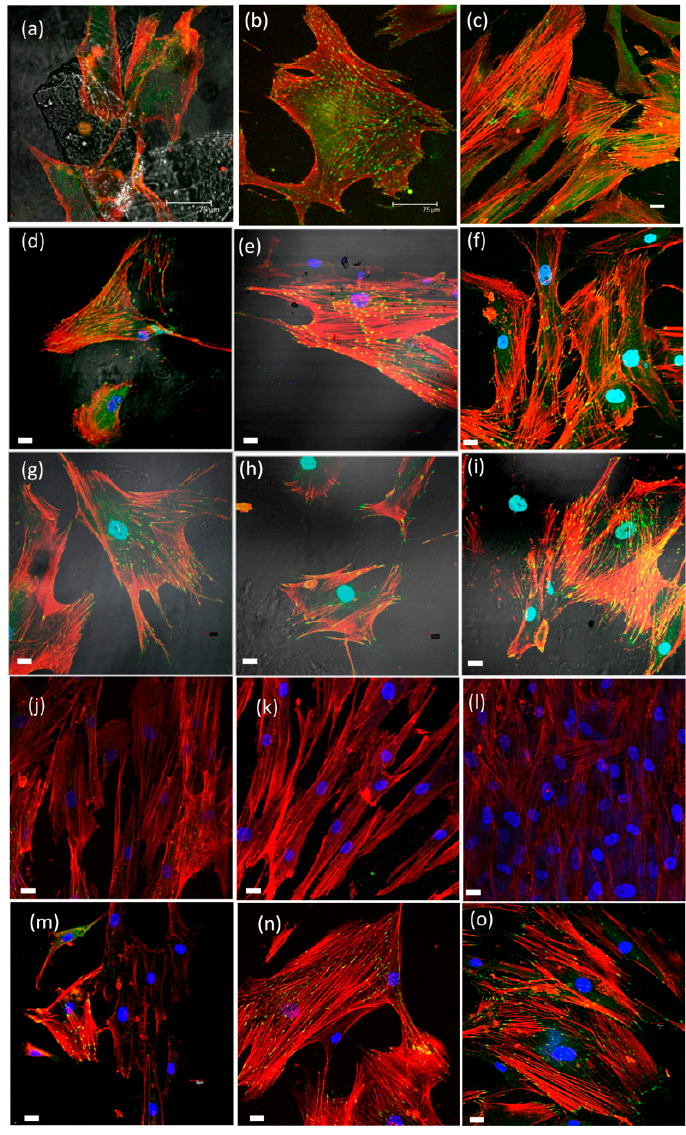
Figure 9. Representative images of HOB® osteoblasts growing in the presence of: ( a ) xerogel SCS8T10_U, after 48 h in culture; ( b ) after 72 h in culture; ( c ) after 1 week in culture; ( d ) xerogel SCS8T10_E1, after 48 h in culture; ( e ) after 72 h in culture; ( f ) after 1 week in culture; ( g ) SCS8T10_E7, after 48 h in culture; ( h ) after 72 h in culture; ( i ) after 1 week in culture; ( j ) SCS8T20U after 48 h in culture; ( k ) after 72 h in culture; ( l ) after 1 week in culture; ( m ) control 48 h; ( n ) control 72 h; ( o ) control 1 week. Images acquired in the confocal microscope after immunolabelling of actin cytoskeleton with rhodamine phalloidin (fluoresces red) and vinculin (fluoresces green) for focal adhesions. Blue, DAPI-labelled nuclei. Unless specified, scale bar equals 20 µ